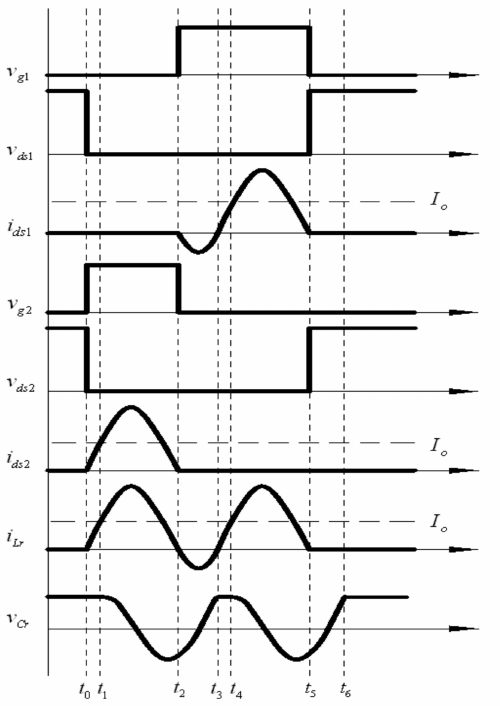
Figure 2. Illustrated waveforms relevant to the proposed resonant buck converter